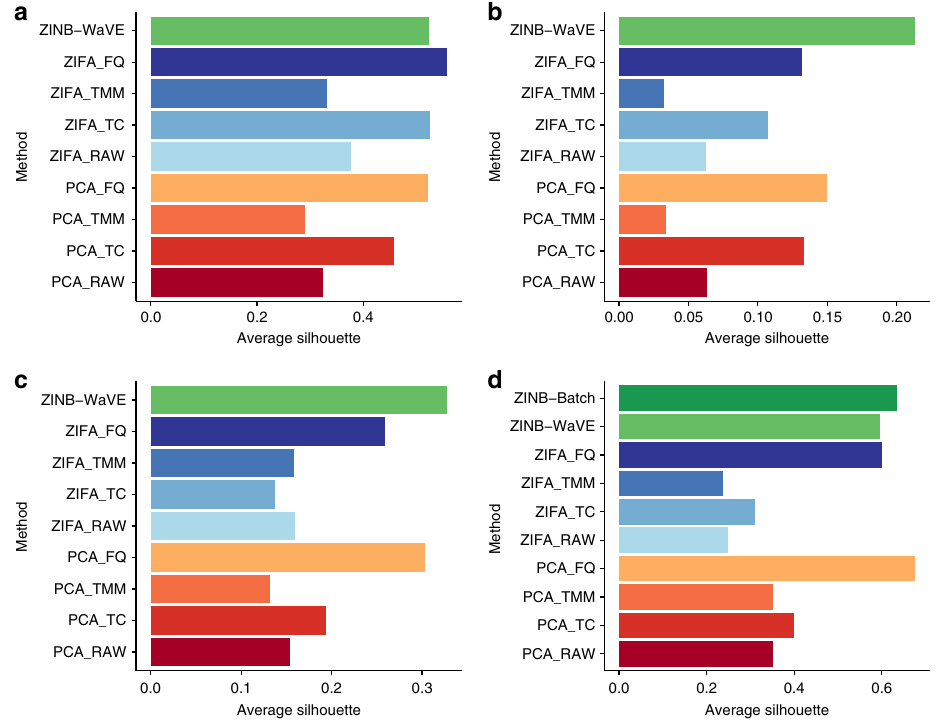
Fig. 4 Average silhouette width in real data sets. a V1 data set; b S1/CA1 data set; c glioblastoma data set; d mESC data set. Silhouette widths were computed in the low-dimensional space, using the groupings provided by the authors of the original publications: unsupervised clustering procedure ( a , b ), observed characteristics of the samples, such as patient ( c ) and culture condition ( d ). PCA and ZIFA were applied after normalization: unnormalized (RAW), total count (TC), trimmed mean of M values (TMM), and full-quantile (FQ). For the mESC data set ( d ), we fi tted the ZINB-WaVE model with batch as a sample-level covariate (ZINB-Batch) in addition to the default model with only a sample-level intercept (see Fig.